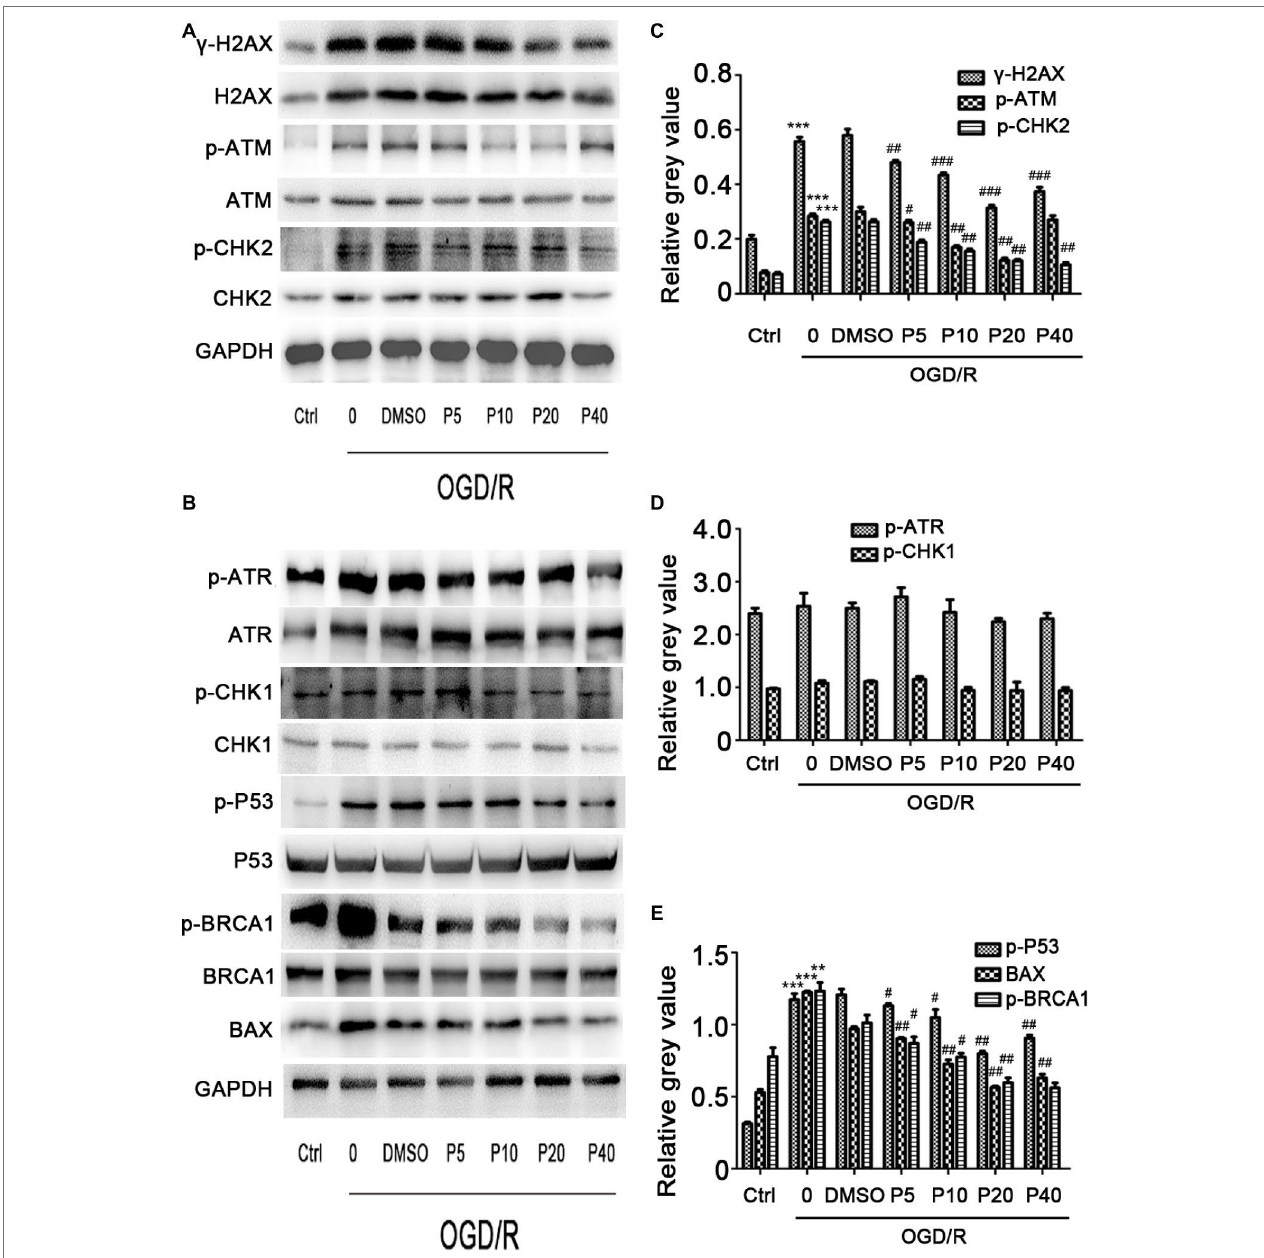
FIGURE 3 | The effects of propofol on the expression of DNA double-strand break-related proteins induced by OGD/R in H9c2 cells during OGD/IR insult. Representative bands of (A) γ -H2AX, p-ATM, p-CHK2, (B) p-ATR, p-CHK1, p-BRCA1, p-P53, Bax by western blotting. (C–E) Relative gray value of γ -H2AX, p-ATM, p-CHK2, p-ATR, p-CHK1, p-BRCA1, p-P53, and Bax. GAPDH was used as an internal control. The data are presented as the mean ± SD of three independent experiments. * p < 0.05, ** p < 0.01, *** p < 0.001 versus control, # p < 0.05, ## p < 0.01, ### p < 0.001 versus OGD/R treated group without